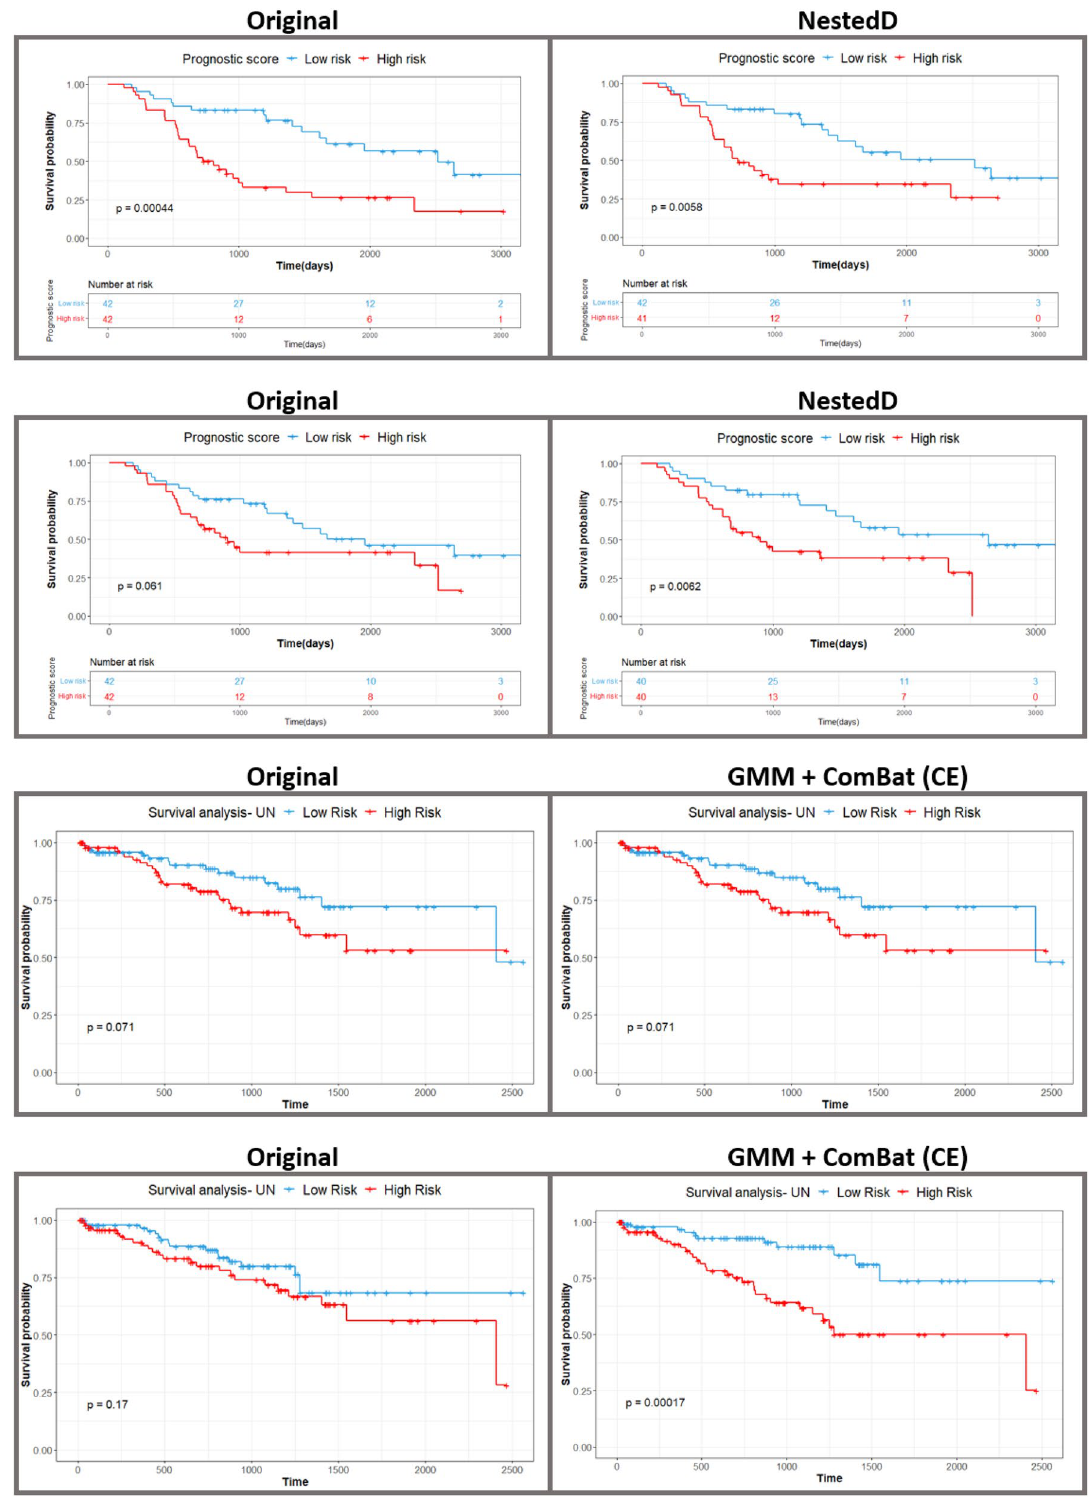
Figure 3. Survival analysis. In-sample Kaplan–Meier curves fitted on the original features and the harmonization approach with the highest c-statistic for each